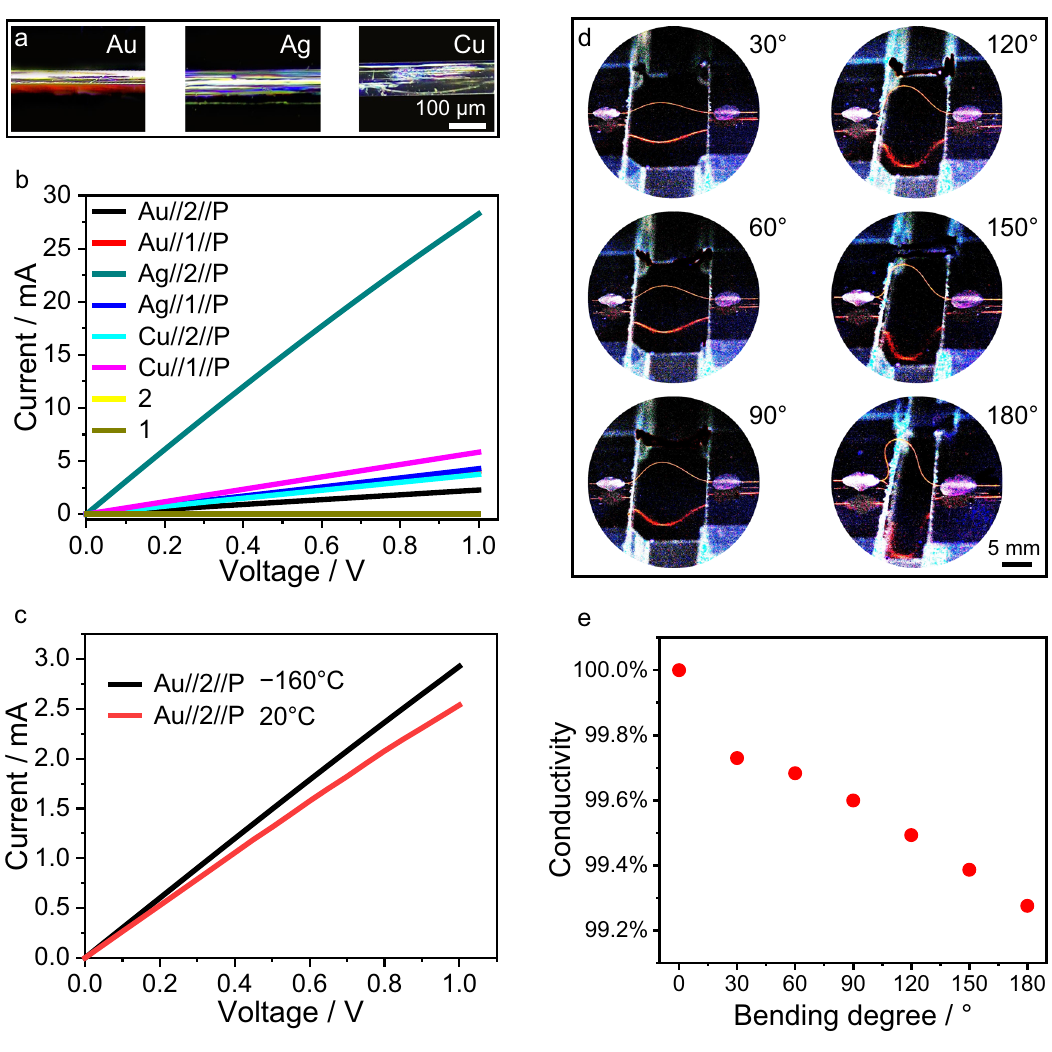
Fig.2|Electricalconductivityofthehybridorganiccrystals.a Opticalimagesof the hybrid organic crystals with different metal coatings (M=Au, Ag, Cu) (top view). b I ‒ V plot of crystals 1, 2 and M//1,2//P. c I ‒ V plot of Au//2//P at different